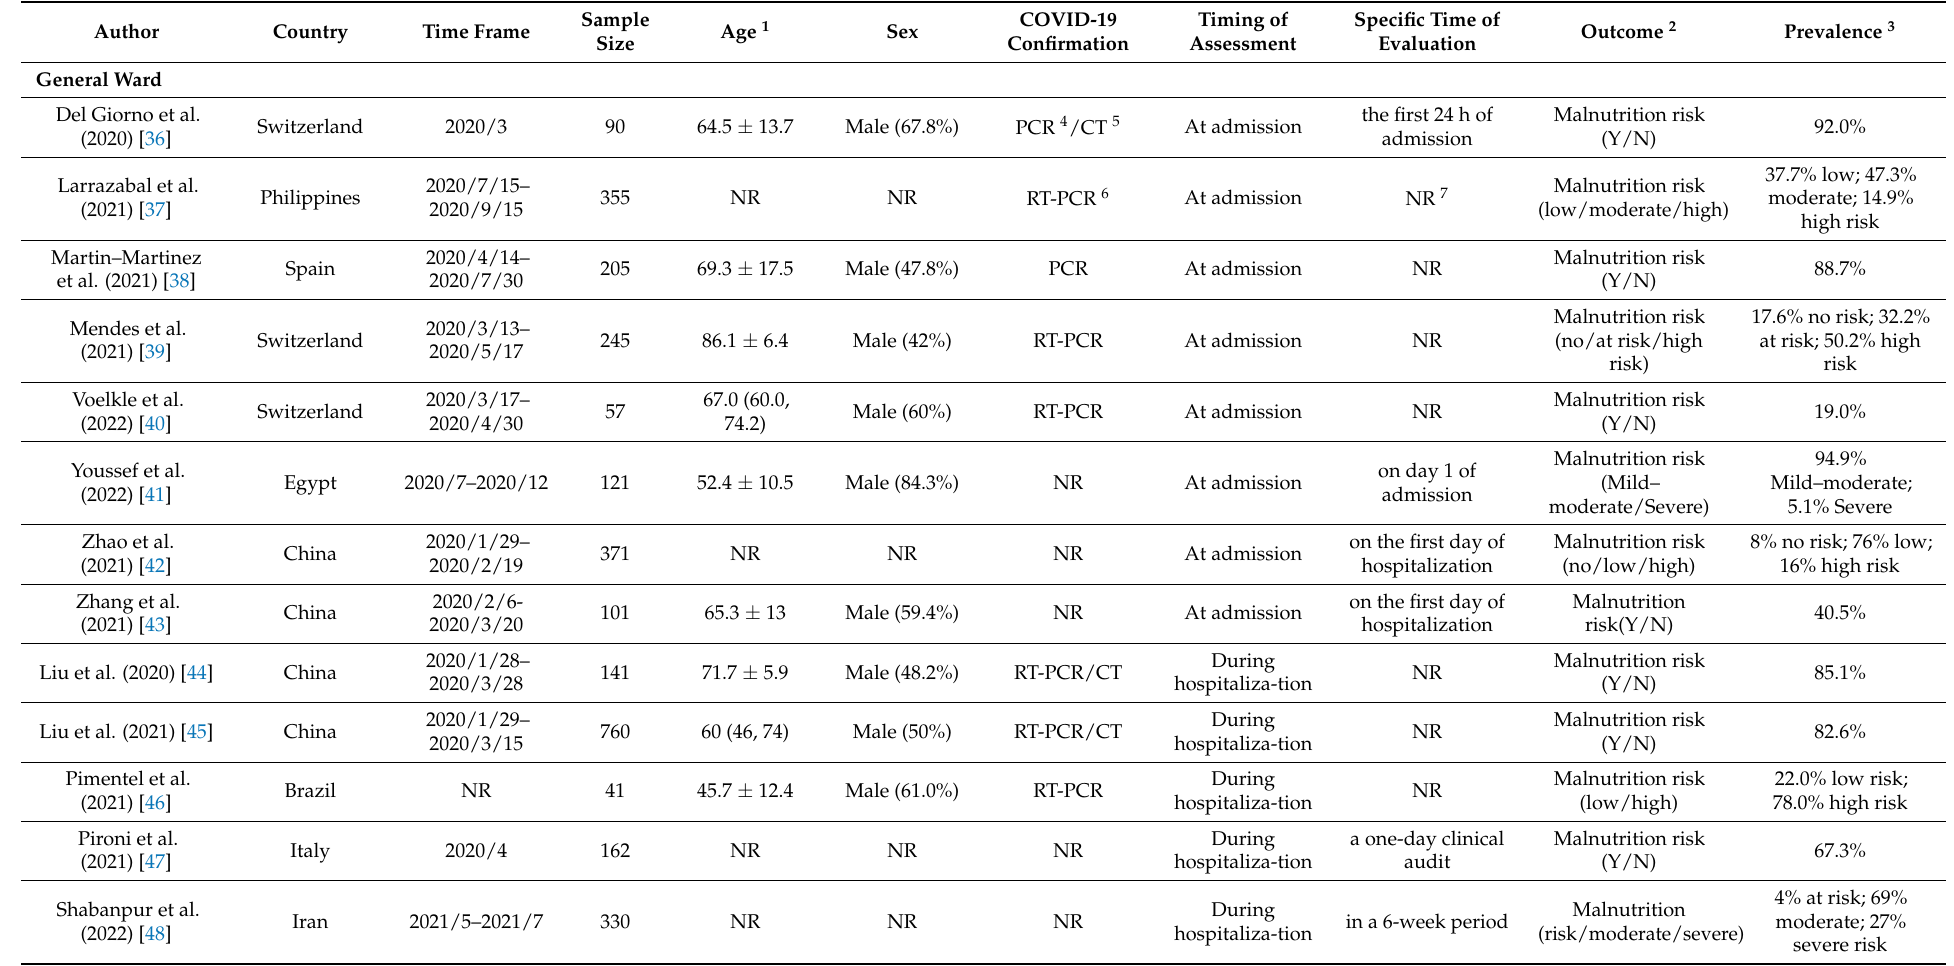
Table 1. Study characteristics of hospitalized COVID-19 patients assessed by Nutritional Risk